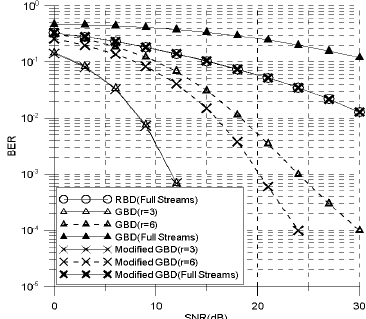
Figure 4. The bit error rate (BER) comparison when each of the 3 UEs has 3 receive antennas and the base station (BS) has 9 transmit antennas.